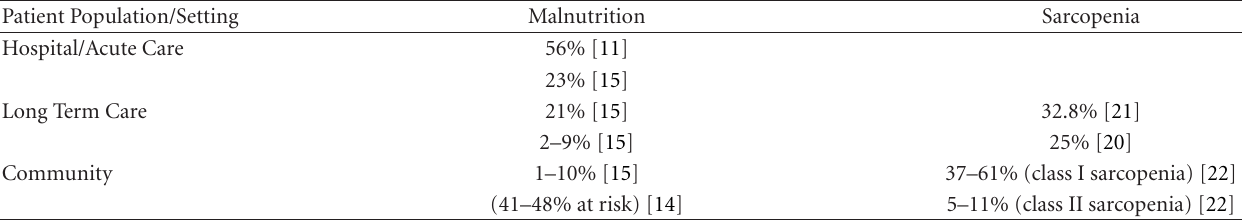
Figure 1: EUGMS working group-suggested algorithm for sarcopenia case finding in older individuals (used with permission) [9]. Table 1: Prevalence of malnutrition and sarcopenia in older adults across clinical settings. Patient Population/Setting Malnutrition